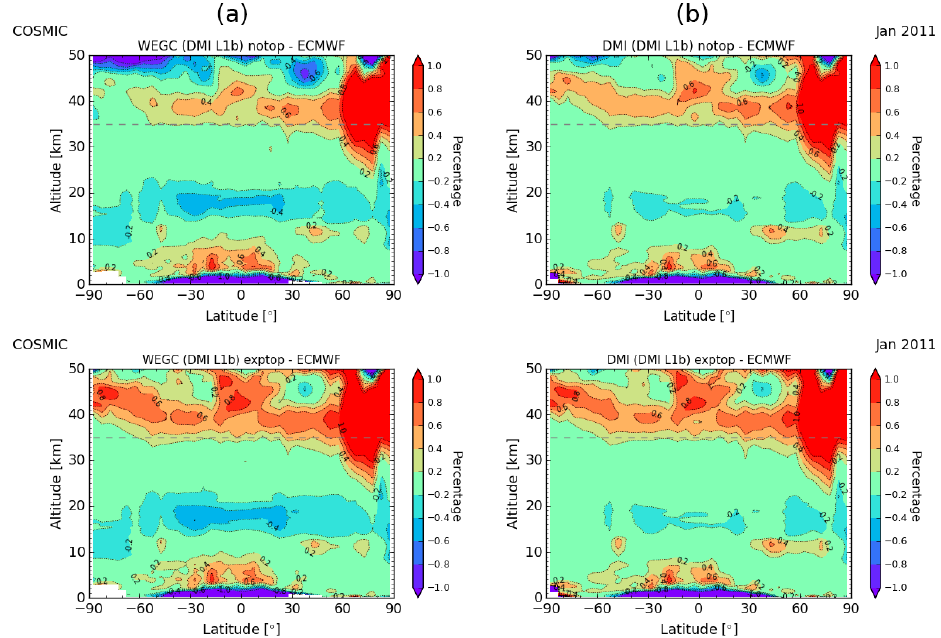
Figure 7. API refractivity climatologies relative to ECMWF analyses, comparing WEGC processing (a) to DMI processing (b) , for notop (first row) and exptop (second row), exemplary for January